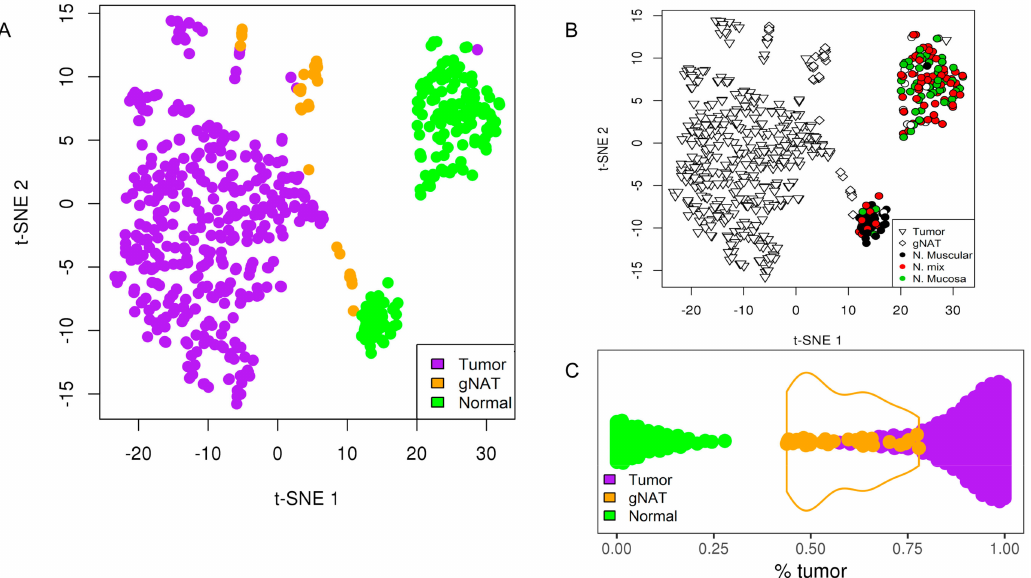
Figure 1. Scatter plot of the samples after dimensionality reduction procedure. ( A ) Gastric cancer (GC) in purple, gNAT in orange and normal tissue in green; ( B ) GC and gNAT with no fill while normal tissue in black red or green according to the anatomopathological classification as muscular, mixed or mucosa. ( C ) Deconvolution highlighting the tumor / normal fraction for each sample. GC in purple, gNAT in orange and normal tissue (only mucosa) in green. In orange violin plot overlay of the gNAT